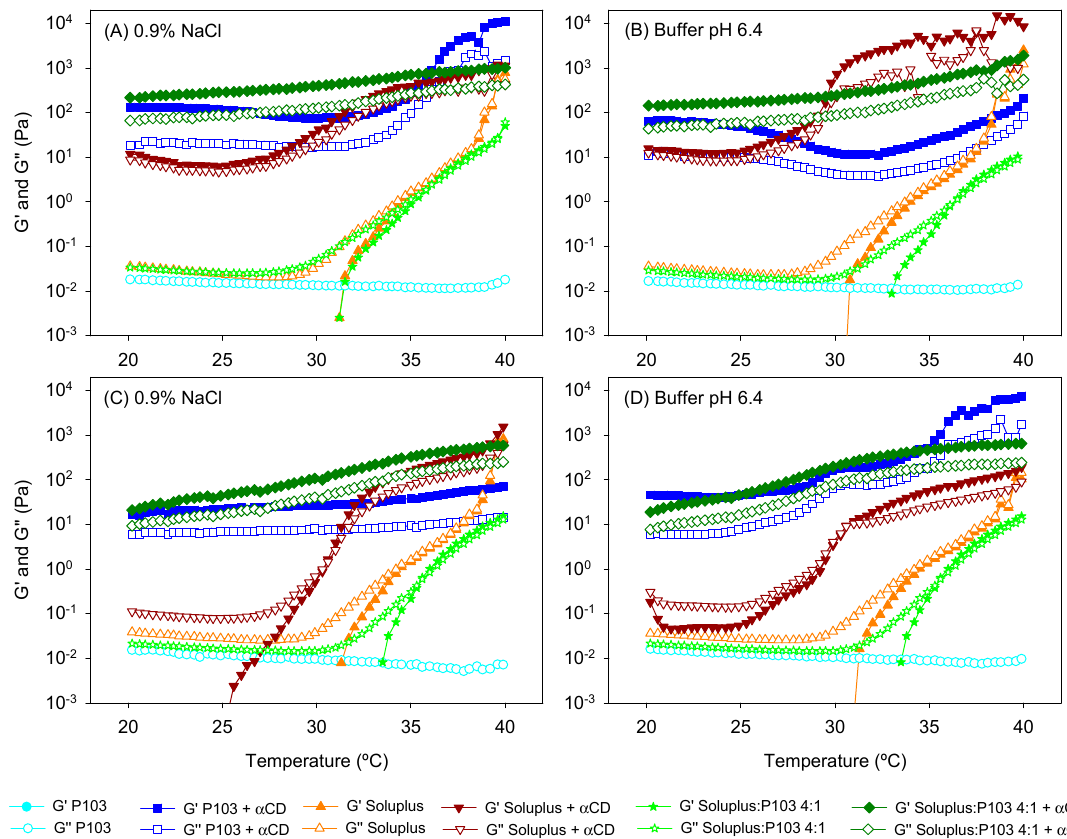
Figure 5. Evolution of the storage (G ′ ) and the loss (G ″ ) moduli as a function of temperature of ( A , B ) unloaded and ( C , D ) drug-loaded copolymer dispersions and their mixtures with and without α -cyclodextrin ( α CD) (poly(pseudo)rotaxanes) in 0.9% NaCl (left) and pH 6.4 buffer (right). Total copolymer concentration was 10% w / v in all cases.